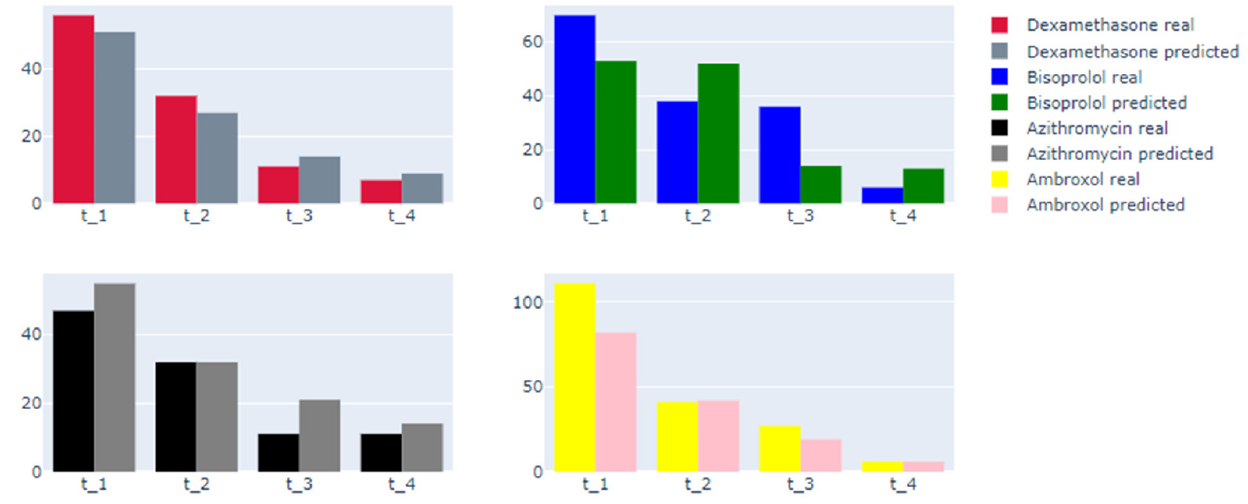
Figure 12. Comparison of real and predictive counts of drug prescribing.